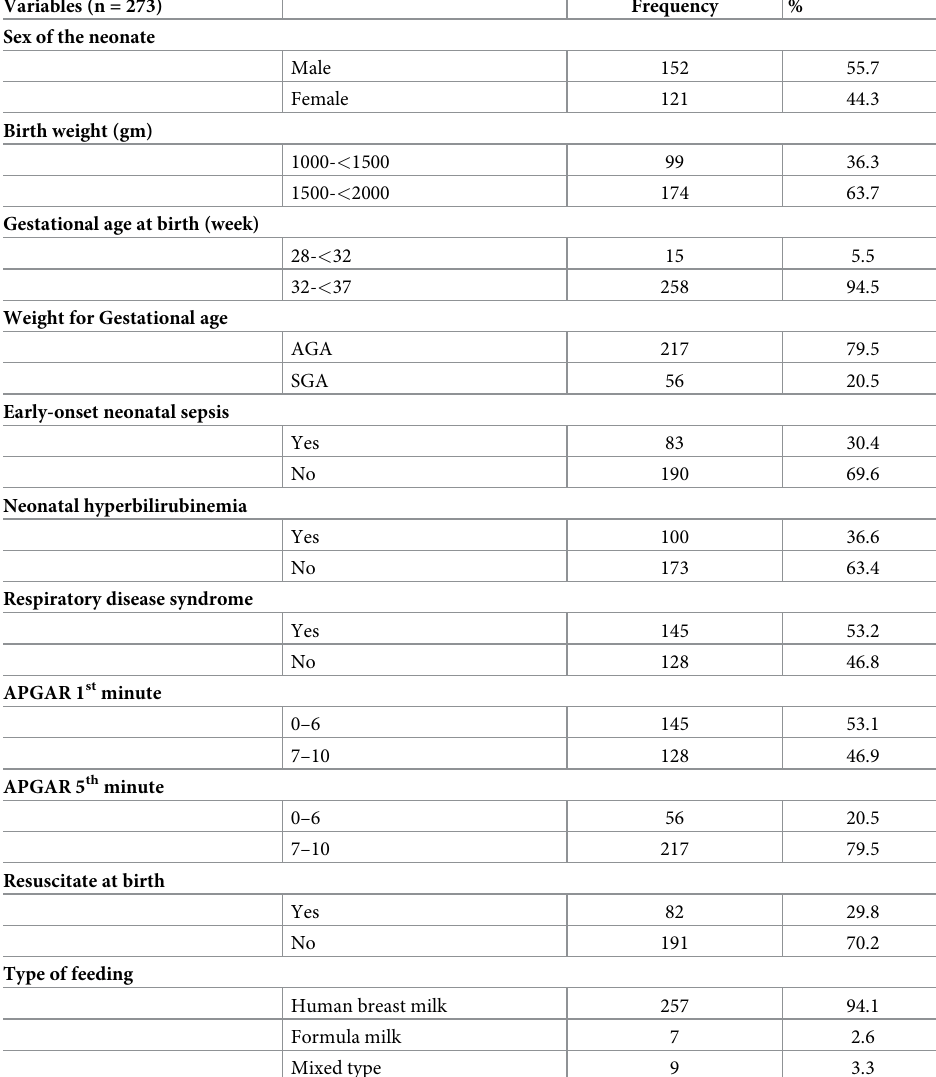
Table 2. Neonatal demographic and clinical characteristics of LBW neonates admitted to the neonatal ICU in Hawassa city, Sidama region Ethiopia, 2019. Variables (n =